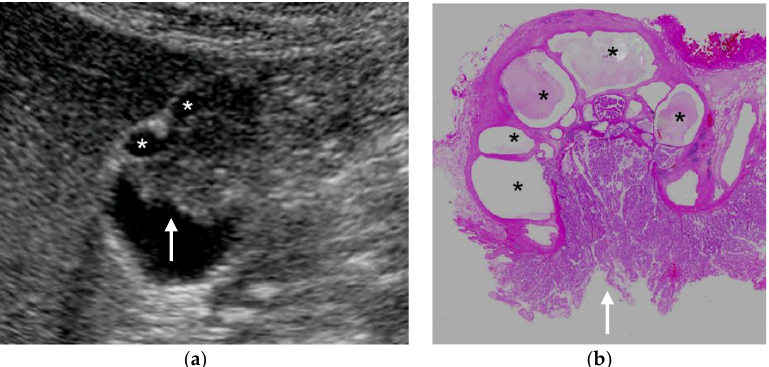
Figure 8. GBC concomitant with localized ADM. ( a ) US showed a papillary GPL (arrow) with dilated cystic lesions in the fundus. ( b ) Histopathologically, a papillary GBC (arrow) arose in the surface mucosa of localized ADM and cystic lesions were corresponding to dilated RASs (*: dilated RAS). Reprinted with permission from ref. [7]. Copyright 2021 Japan Society of Ultrasonics in